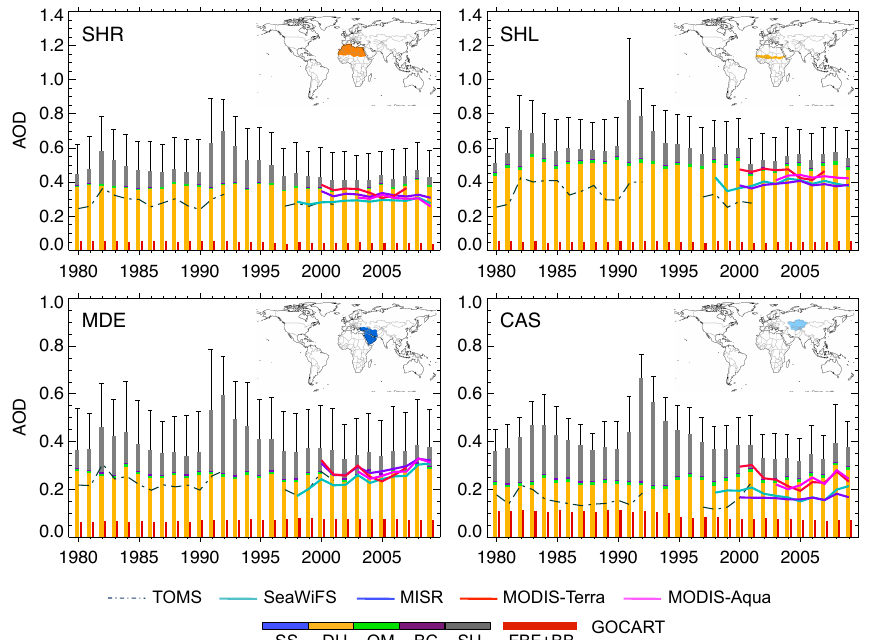
Fig. 6b. Same as Fig. 6a but for four dust source regions of SHR, SHL, MDE, and